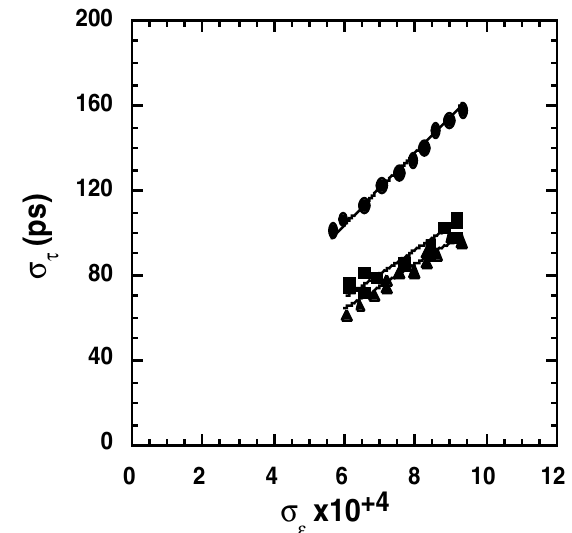
FIG. 2. Bunch length (cid:1) measured in the absence of a laser: ( (cid:2) ) for V (cid:1) 90 kV , and ( (cid:3) ) for V V h